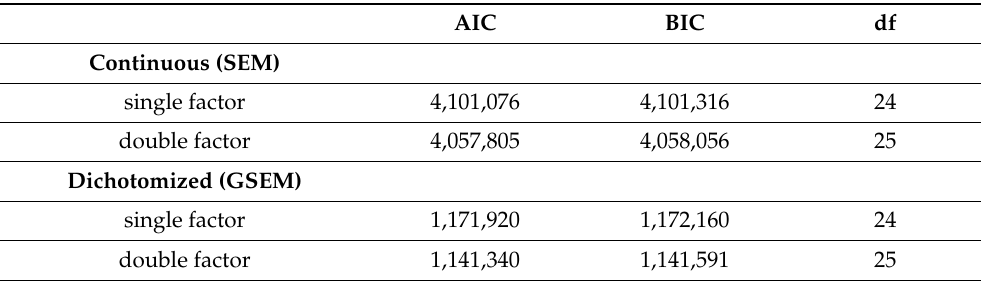
Figure A1. Confirmatory Factor Analysis on health complaints. Results from the double factor (PSY-HC and SOM-HC) model for the dichotomized variable. Standardized coefficients of correlation between latent and observed variables. Abbreviations. HC: ≥ 2 health complaints more than once a week; PSY-HC: ≥ 2 psychological health complaints more than once a week; SOM-HC: ≥ 2 somatic health complaints more than once a week. Table A1. Confirmatory factor analysis (SEM, GSEM). Measures of fit (AIC, BIC) between a single factor (HC) and a double factor (PSY-HC and SOM-HC) model for health complaints, both dichotomized variable and score.